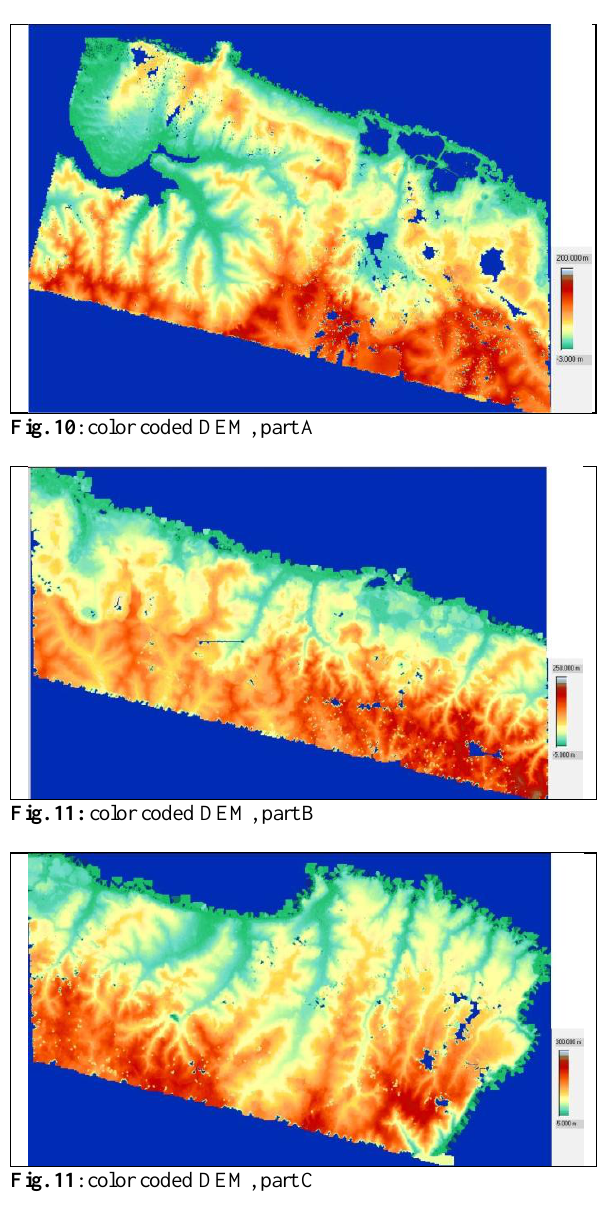
Fig. 11 : color coded DEM, part C